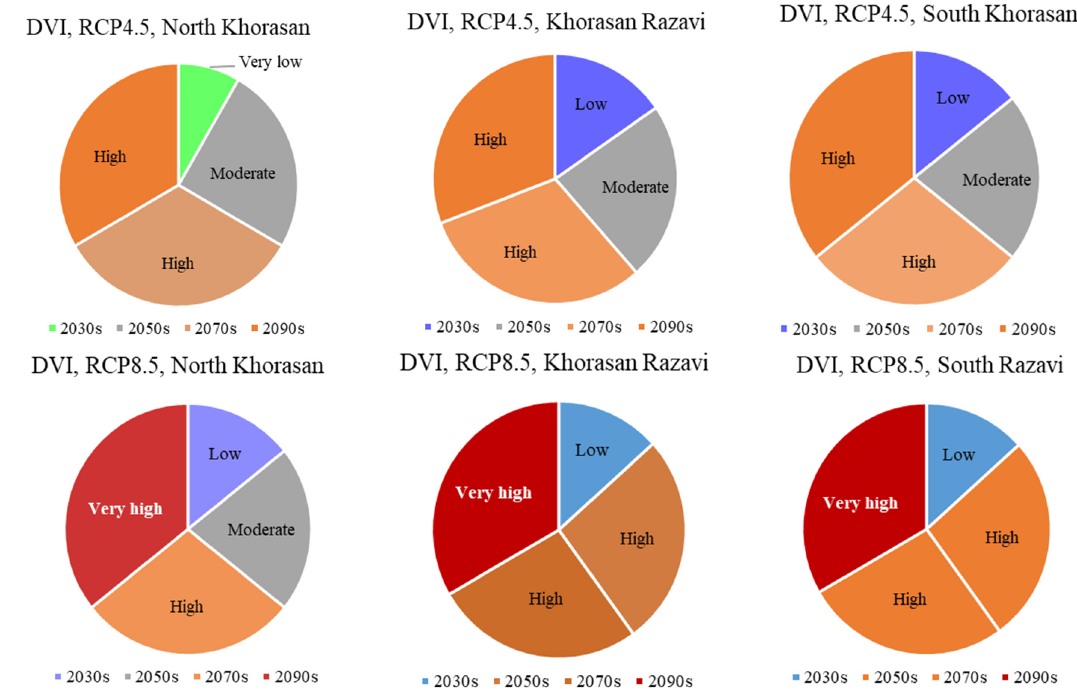
Figure 10. Maps showing the projected level of Drought Vulnerability Index (DVI) over North Khorasan, Khorasan-Razavi, and South Khorasan provinces under RCP4.5 ( above ) and RCP8.5 ( below ).